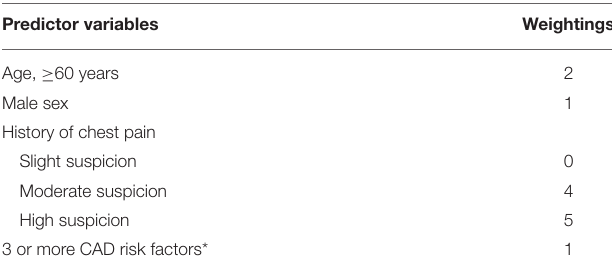
TABLE 3 | Weightings of the predictor variables in the final